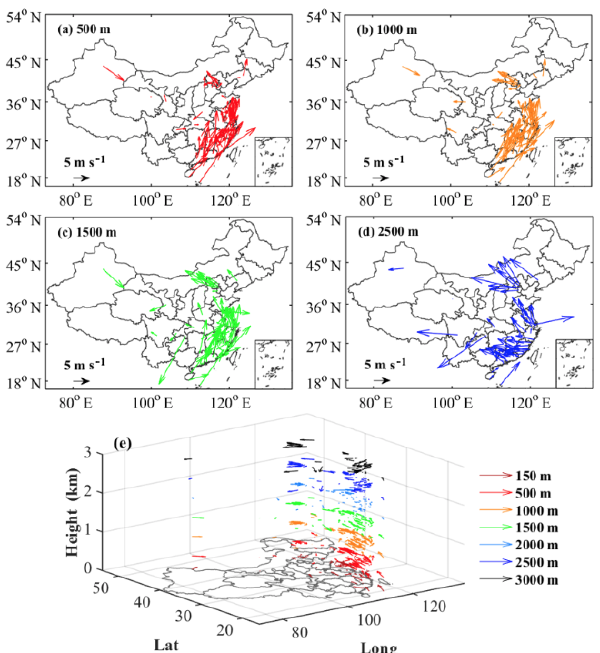
Figure 4. Spatial distribution of (a) mean effective detection height, (c) mean data acquisition rate and (e) mean data confidence at each station during November 2018 to March 2019; (b) , (d) and (f) cor- respond to the histograms for (a) , (c) and (e) ,